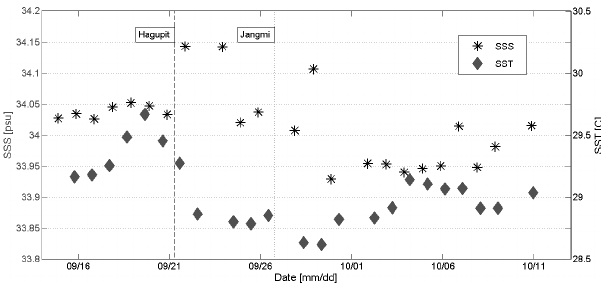
Figure 9. Argo float surface salinity (SSS) [psu] (left axis) and sea surface temperature [ ◦ C] (right axis) at 4m Fig. 9. Argo float surface salinity SSS [psu] (left axis) and sea surface temperature [C] (right 3 axis) at 4 m depth. 4